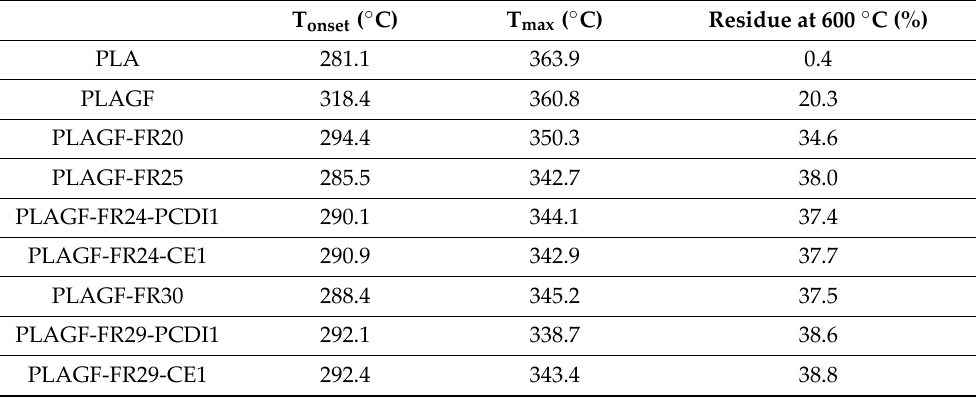
Figure 8. TG curves of the neat PLA and PLA-GF composites ( a ) comparison with 25 wt% FR content ( b ) comparison with 30 wt% FR content; and DTG graphs with ( c ) 25 wt% and ( d ) 30 wt% FR. Table 7. TGA data of the PLA and PLA-composites.